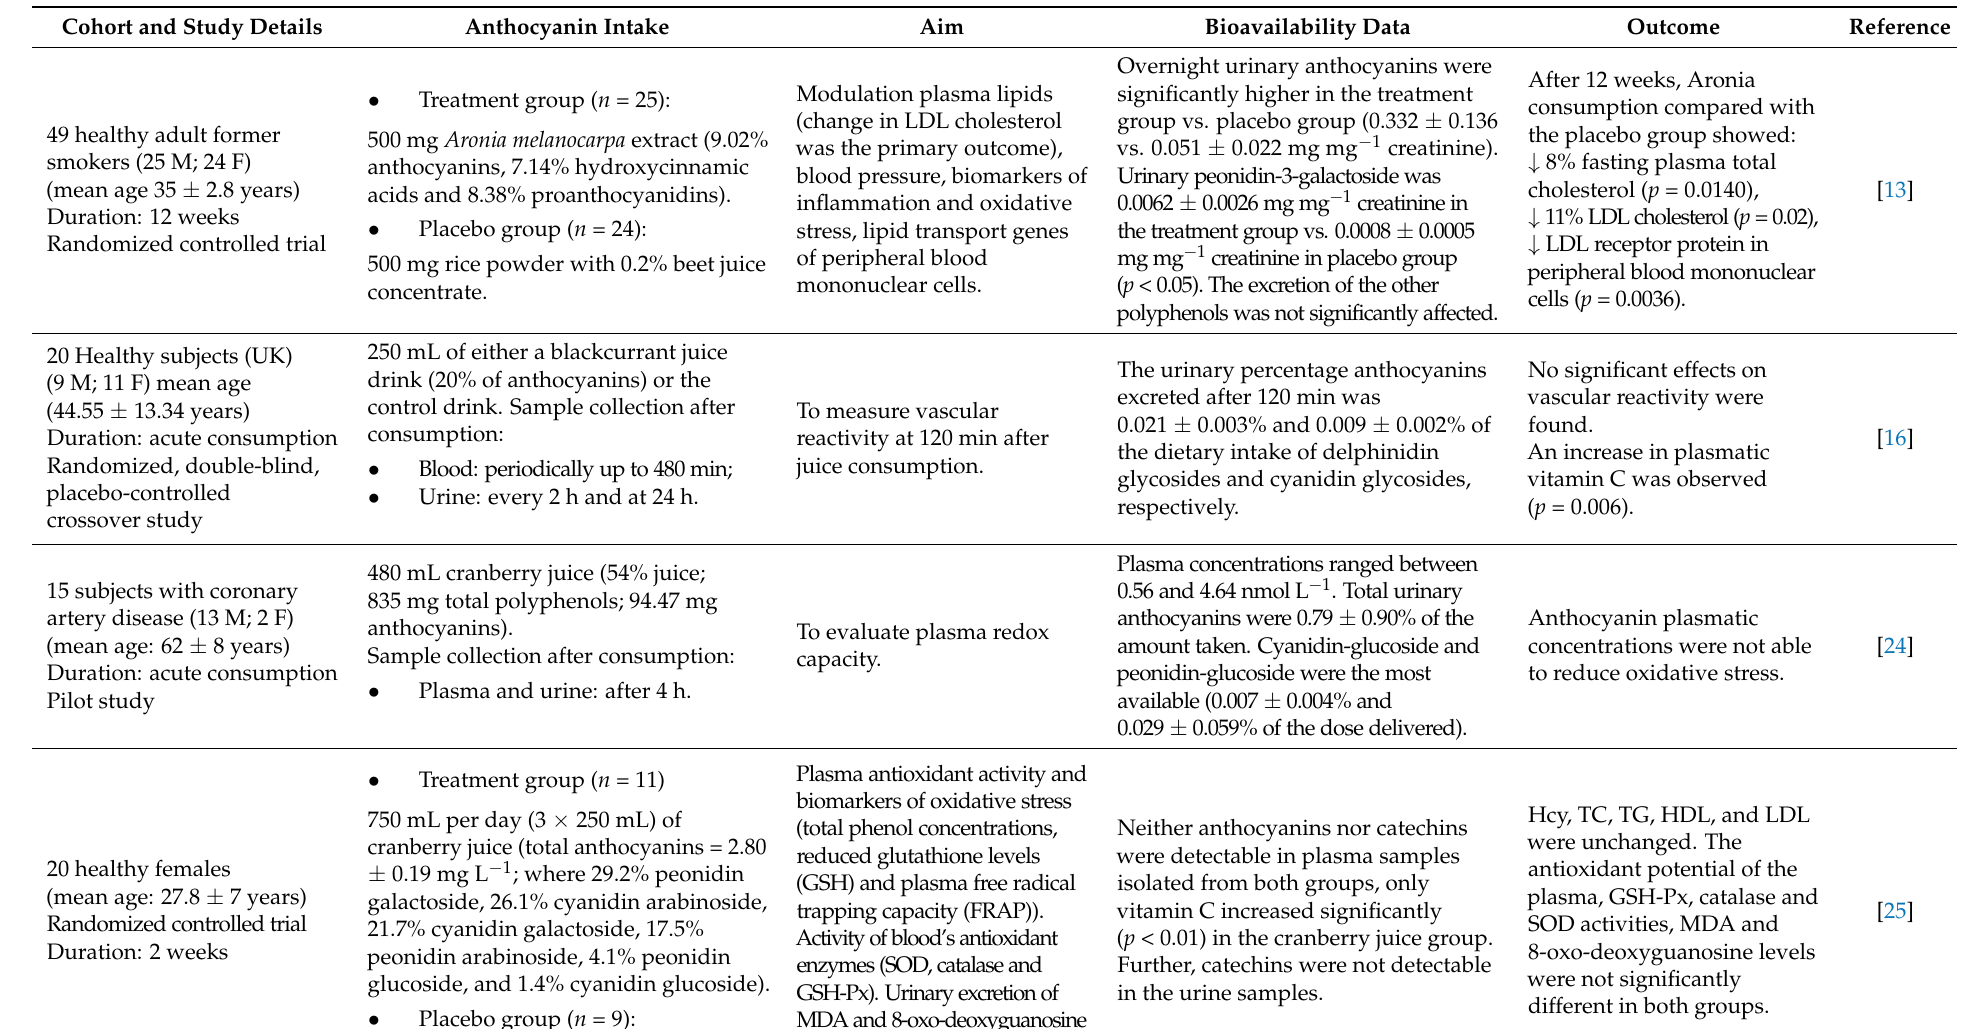
Table 1. Anthocyanin’s beneficial effects and bioavailability in human